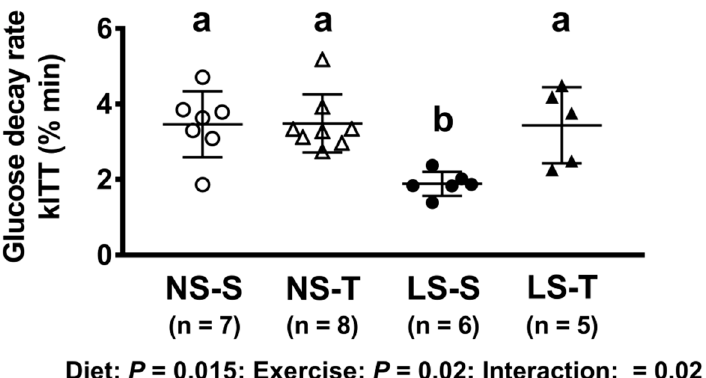
Figure 3. Glucose decay rate in insulin tolerance test (kITT, % min). Data presented as mean ± SD. Results compared by 2-way ANOVA (GLM; fixed factor: diet and exercise) with Tukey’s post hoc test. p diet = 0.02; p exercise = 0.02; p diet*exercise = 0.02. Distinct letters represent statistical differences among groups ( p < 0.05). NS = normal-sodium diet; LS = low-sodium diet; S = sedentary; T = trained.